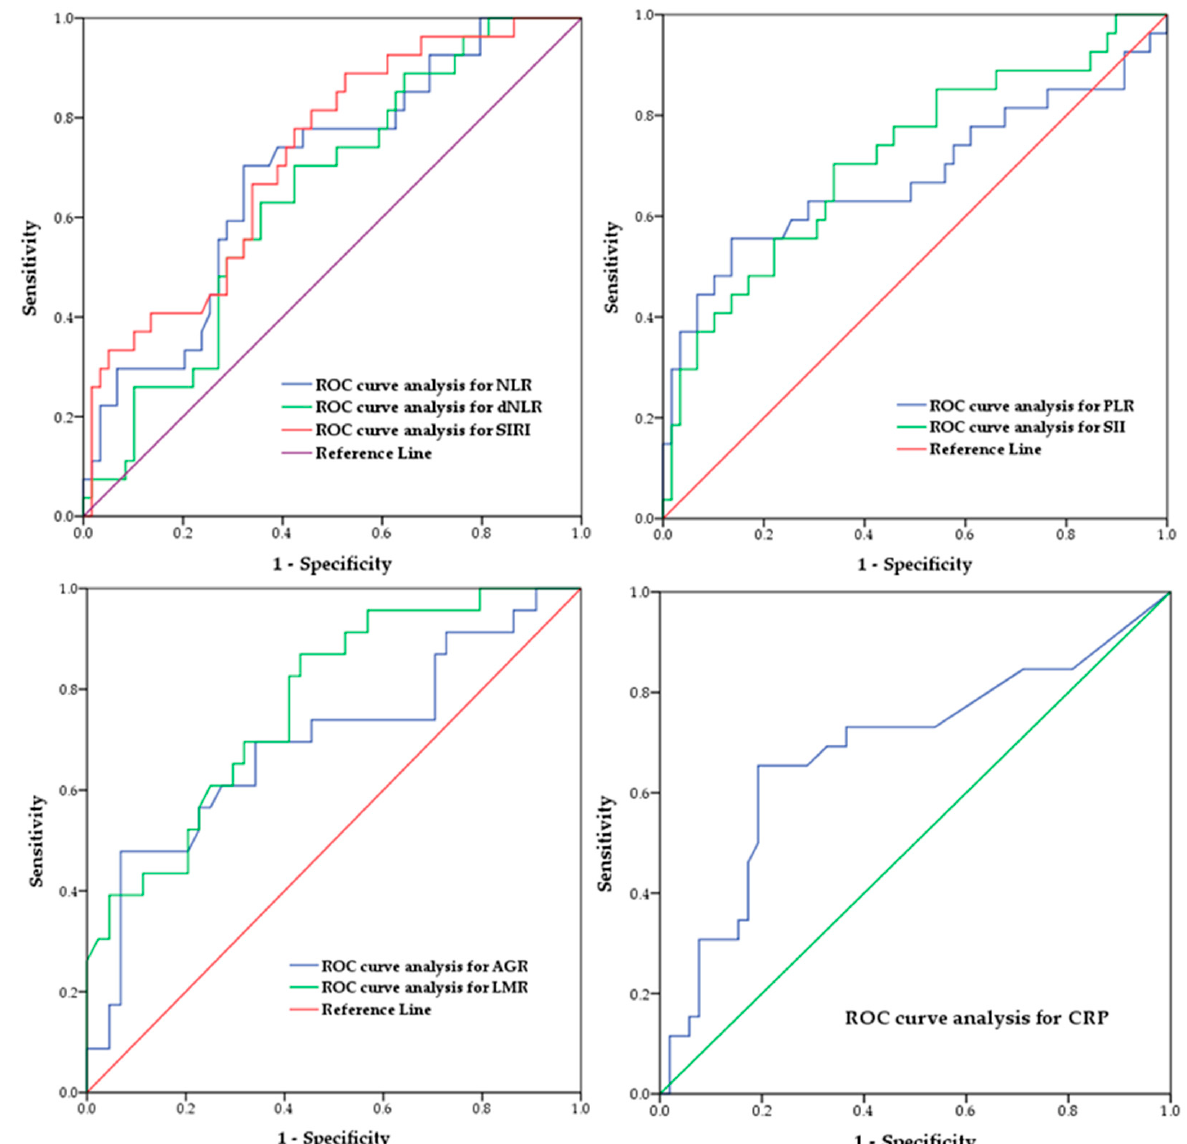
Figure 1. Graphical presentation of receiver operating characteristic (ROC) curve analysis for preoperative inflammatory indices’ performance in predicting metastatic disease among patients diagnosed with testicular GCT.